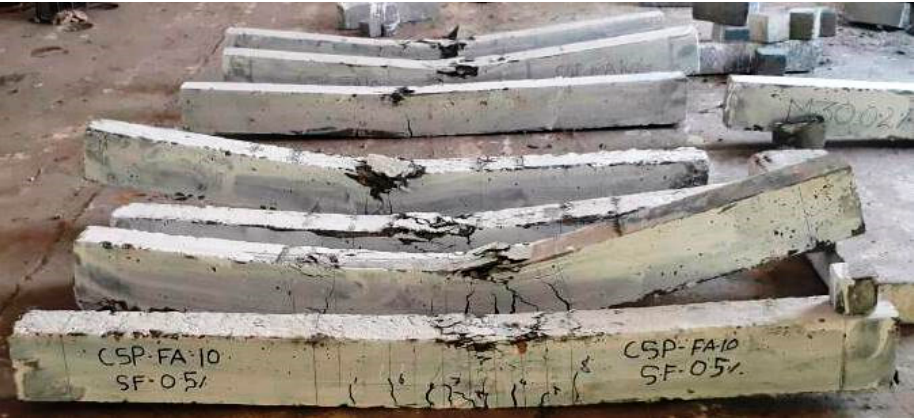
Figure 7. The beams tested for flexure (CS, CSF25, CSF 50, CSF 75, and CSF100).